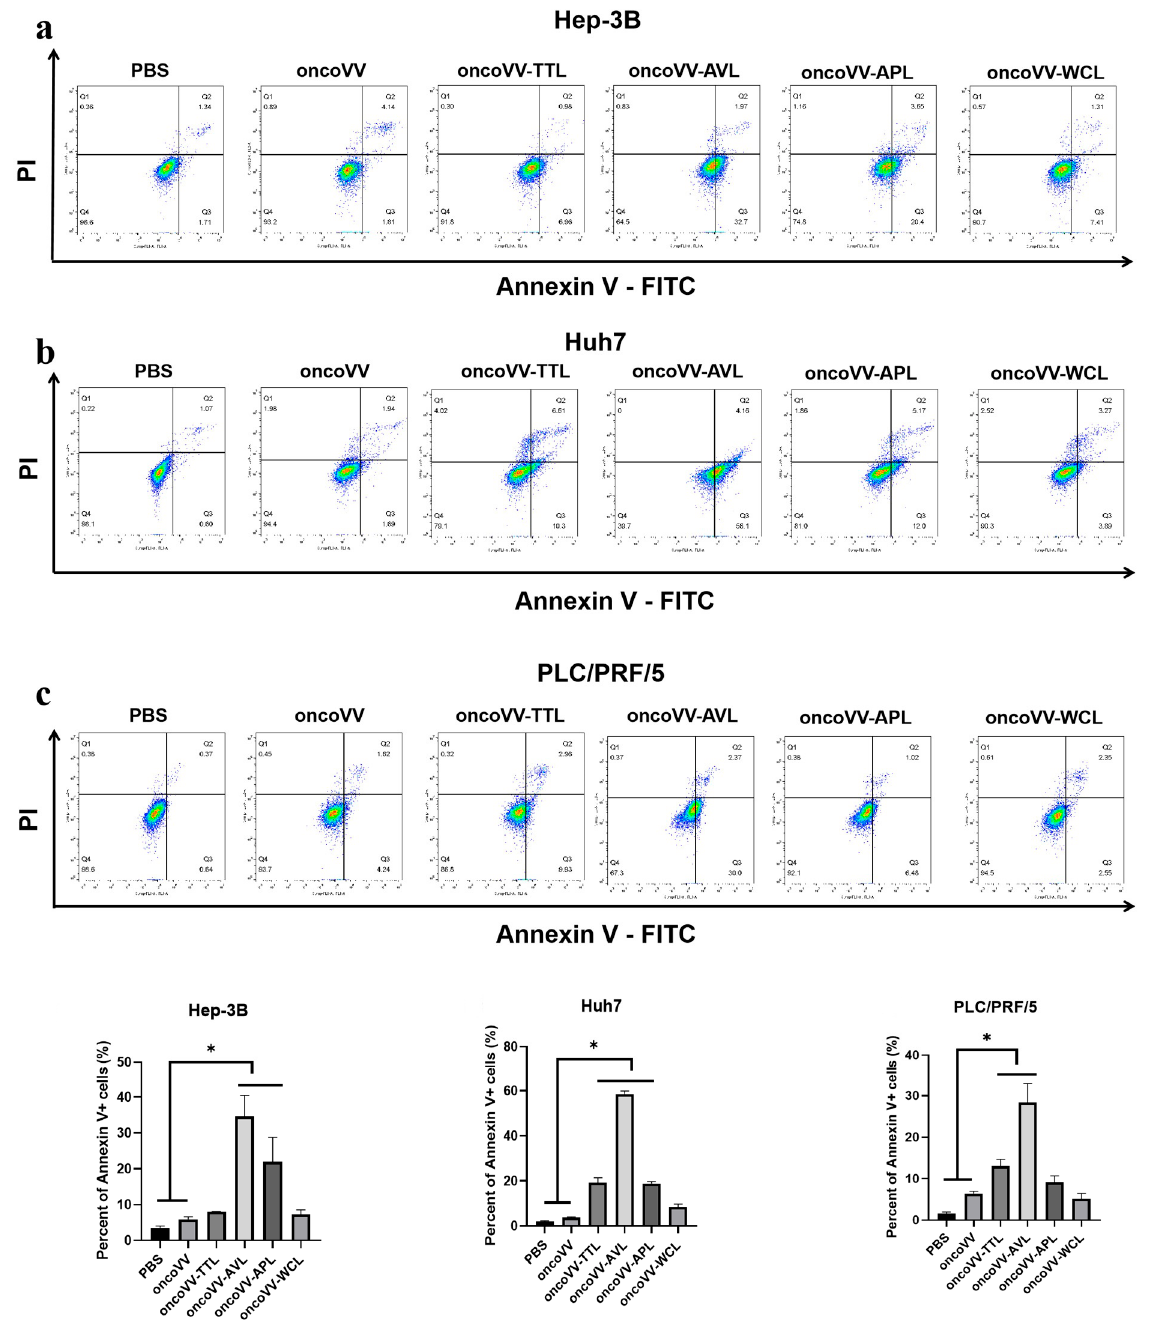
Figure 2. OncoVV-lectins induce apoptosis in Hep-3B ( a ), Huh7 ( b ), and PLC/PRF/5 ( c ) cells. Cells treated with PBS, oncoVV, or recombinant viruses (5 MOI) were harvested after 36 h, and then stained with annexin V-FITC and propidium iodide (PI). The apoptosis rates of Hep-3B ( a ), Huh7 ( b ), and PLC/PRF/5 ( c ) cells were immediately detected by flow cytometry. PBS and oncoVV served as controls (* p < 0.05).